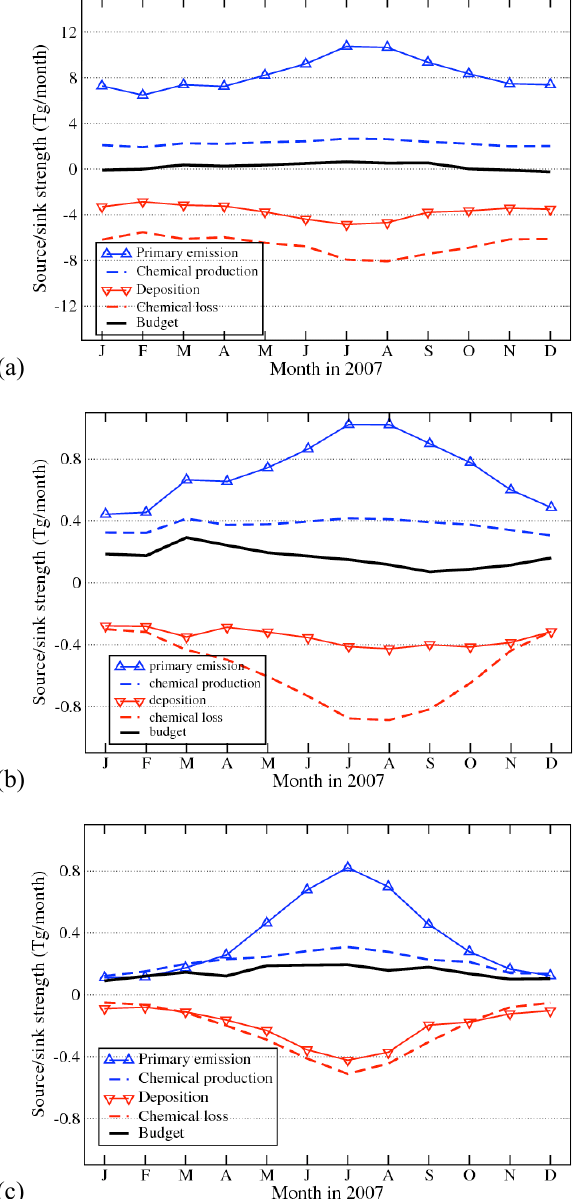
Figure 1. Annual cycle of the acetone budget terms (in Tg/month), computed by LMDz- Fig. 1. Annual cycle of the acetone budget terms (in Tgmonth − 1 ), INCA for (a) the world, (b) South Asia, and (c) Europe. The net budget is computed as computed by LMDz-INCA for (a) the world, (b) South Asia, and source - sink. Sources are divided into primary emission, and chemical production, and sinks (c) Europe. The net budget is computed as source-sink. Sources are (counted negatively) into dry deposition and chemical loss. divided into primary emission, and chemical production, and sinks (counted negatively) into dry deposition and chemical